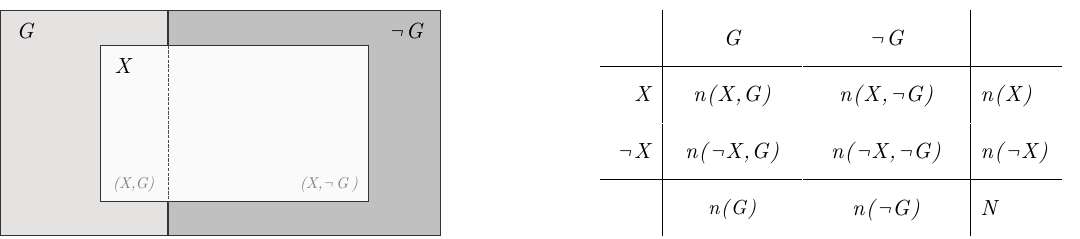
Figure 3. Schematic overview of infrequent contrast pattern mining ( left ). The 2 × 2 contingency table summarising the distribution of a pattern X in a target group G and the background ¬ G of songs in groups other than G ( right ).